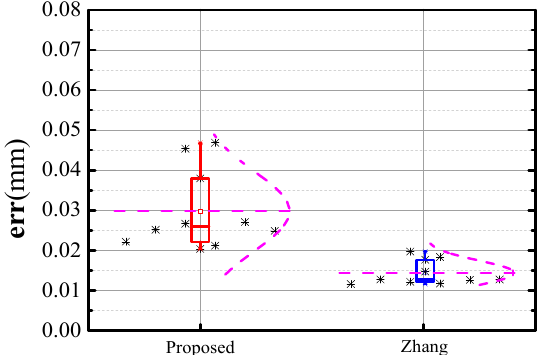
Figure 16. Repeatability of calibration accuracy error via two methods.